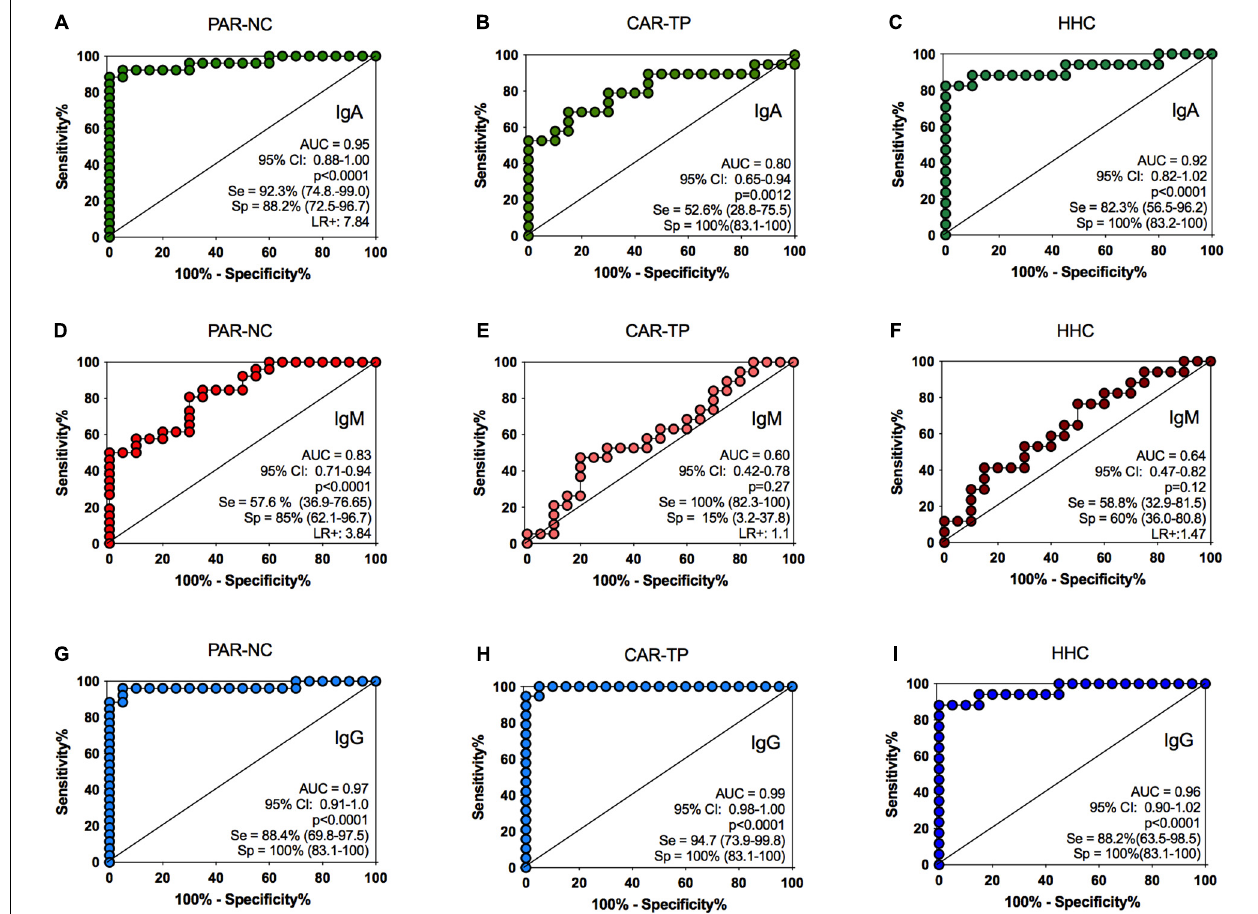
FIGURE 2 | ELISA performance of anti-Mce1A antibody levels. Receiver operating characteristic analysis for comparison of IgA anti-Mce1A (A–C) , IgM anti-Mce1A (D–F) , and IgG anti-Mce1A (G–I) between HD patients and HHC vs. endemic controls. PAR-NC new cases of HD in Parnaíba ( n = 26); CAR-TP patients treated in Colony Carpina ( n = 19); HHC household contacts of HD patients in Parnaíba ( n = 17). AUC, area under the curve; CI, confidence interval; Se, sensitivity; Sp, specificity; LR+, positive likelihood ratio.